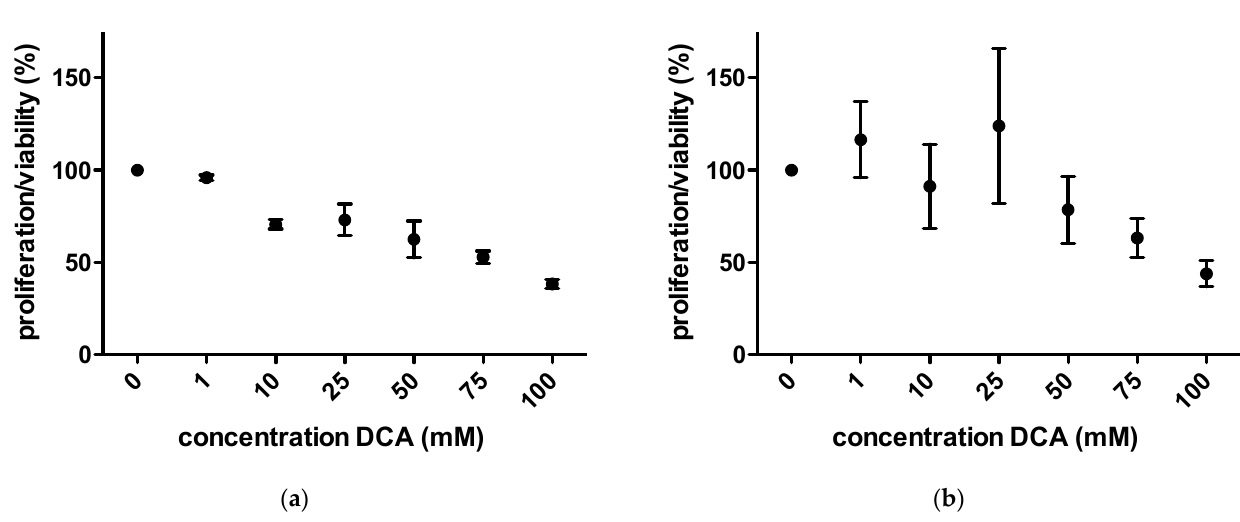
Figure 1. WST ‐ 1 viability/proliferation assays under treatment with DCA. Significant decrease in viability/proliferation in 9580 ( a ) and 10,158 cells ( b ) is shown at concentrations of 75 mM.